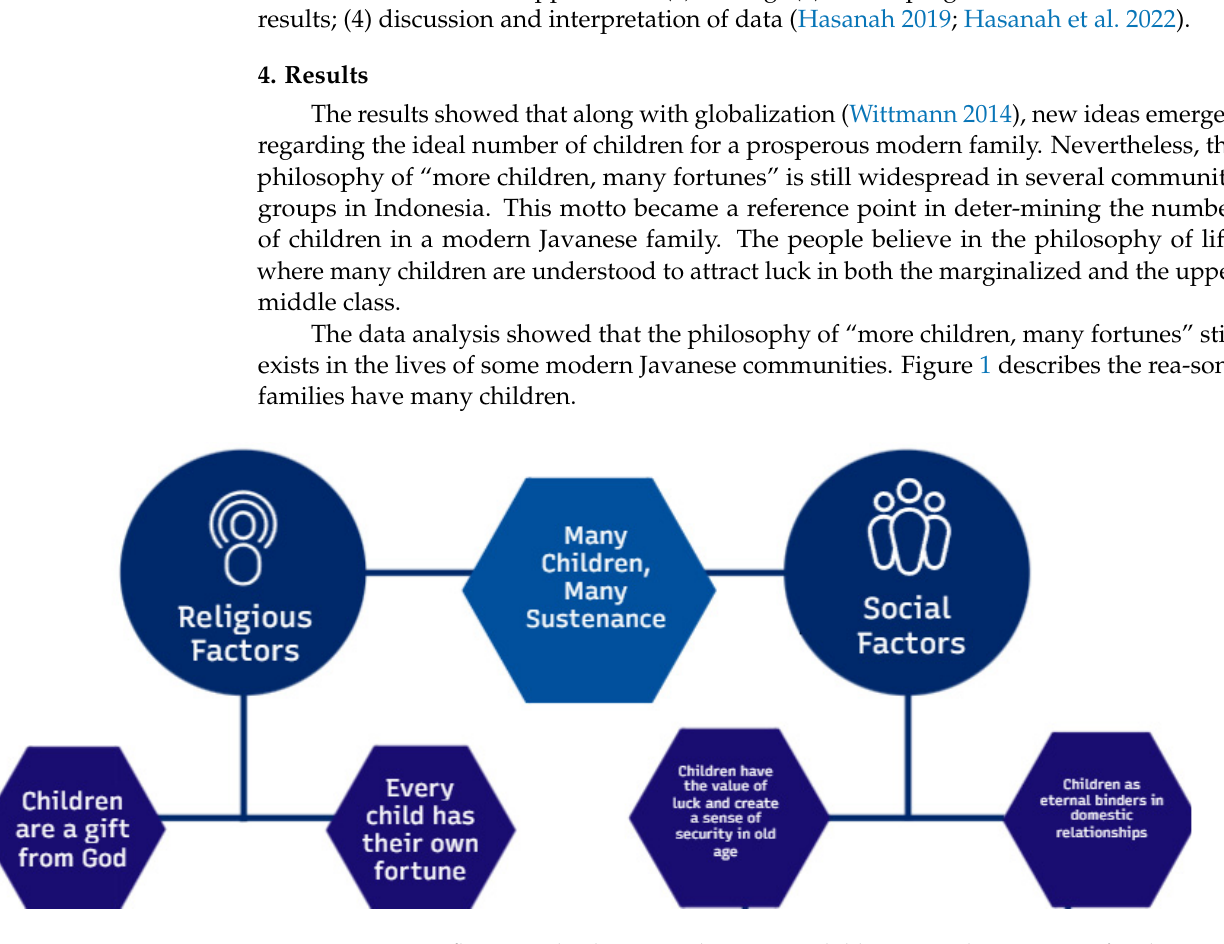
Figure 1. Factors influencing the decision to have many children in modern Javanese